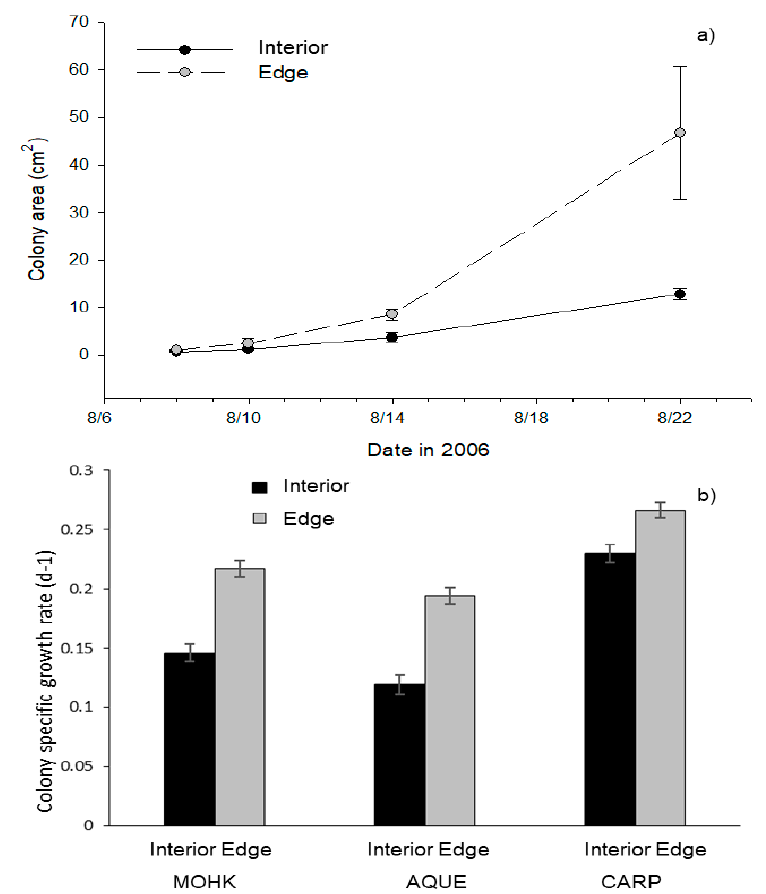
Figure 3. Clonal reproduction (measured as colony specific growth rate, d − 1 ) of Membranipora within and among kelp forests. ( a ) The area of colonies on naturally occurring kelp blades in the interior and along the edge of CARP during August 2006 (mean ± SE). ( b ) The average colony specific growth rates (mean ± SE) for colonies transplanted to the interior (black bars) and along the edge (grey bars) of each forest (MOHK interior (N = 60), MOHK edge (N = 59), AQUE interior (N = 55), AQUE edge (N = 58), CARP interior (N = 52), and CARP edge (N =